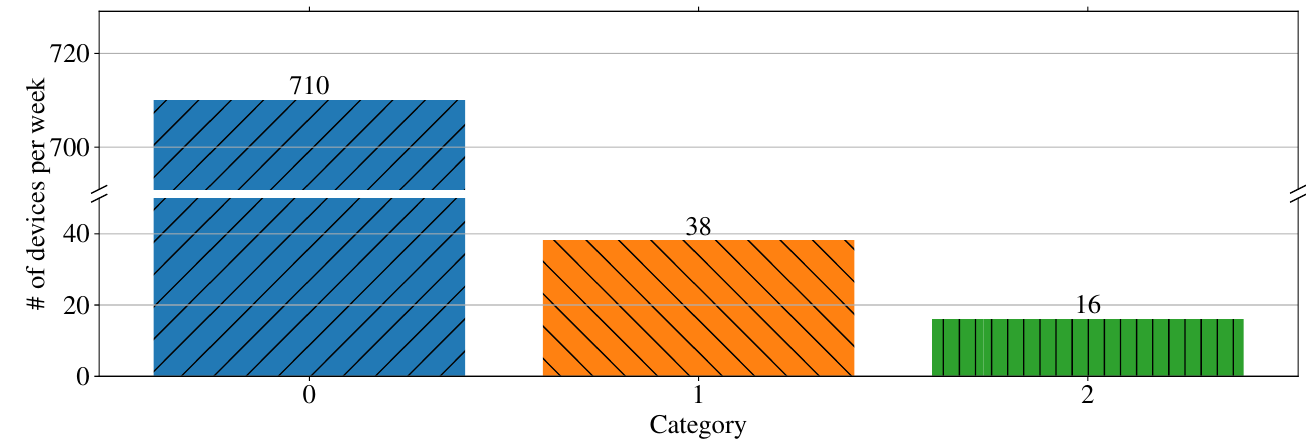
Figure 15. Number of devices per week on different cluster.